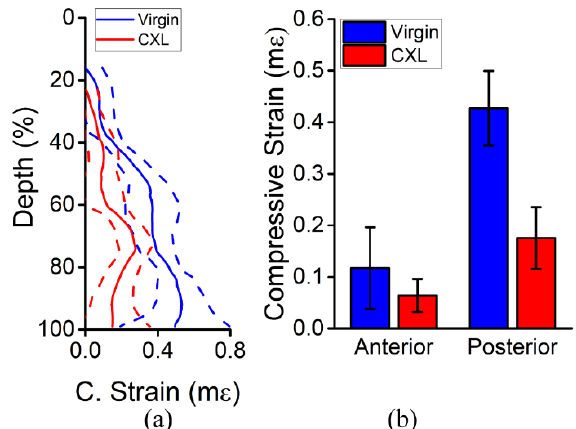
Figure 13. Depth-wise analysis of the half-CXL in vivo rabbit cornea (N = 1). ( a ) Laterally averaged and ( b ) regional analysis of the compressive strain of the virgin and CXL parts of the cornea. The solid lines in ( a ) are the mean, and the dashed lines are one standard deviation of error. The data in ( b ) is the intra-region mean ± standard deviation.